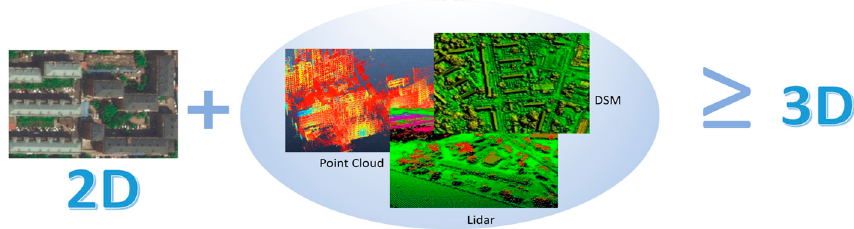
Figure 19. Schematic diagram of the possibility to fuse 2D data with information in other dimensions.